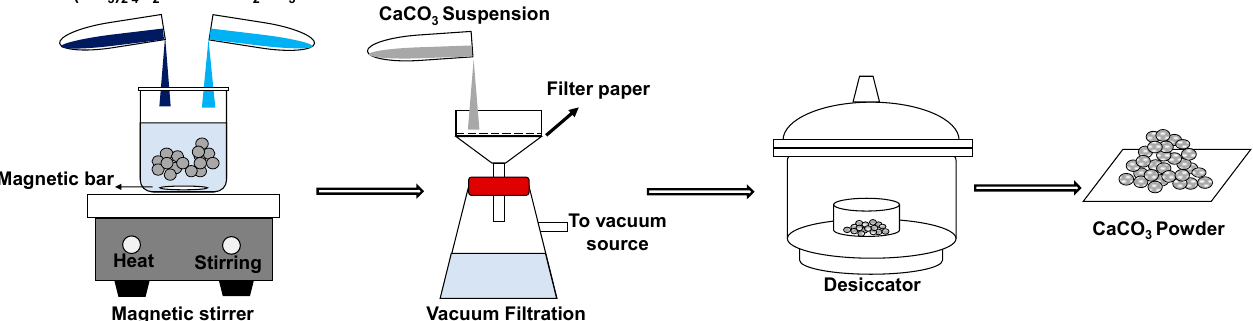
Figure 1. Schematic illustration of synthesis CaCO 3 by a simple procedure. The morphology of the particle was examined by scanning electron microscope (SEM) (Hitachi SU3500, Tokyo, Japan) with an accelerating voltage of 10 kV. A light source was introduced into the cell, and the scattered light was collected at 90 ◦ . The size distribution of primary and secondary particles was obtained using image analysis software ImageJ (NIH Image, Bethesda, MD, USA, version 1.46r: Java 1.6.0_20) from the magnification of SEM images. High-resolution transmission electron microscopy was conducted on Hitachi TEM System with an accelerated voltage of 120 kV. The specific surface area was measured by the Brunauer–Emmett–Teller (BET) method using Quantachrome instruments surface area analyzer (Quantachrome Instrument, Boyn- ton Beach, FL, USA). The small number of samples are dried with nitrogen purging (vacuum) that applies high temperature with pressure tolerance ( P / P 0 ) of 0.050/0.050 (ads/des) as a measurement point. The outgas temperature was 300 ◦ C. The gas volume adsorbed to the surface of the samples is measured at the nitrogen boiling point. It was correlated to the total surface area of the samples, including pore volume and pore diameter, which was calculated based on the BET Equations (2)–(6) [29]: